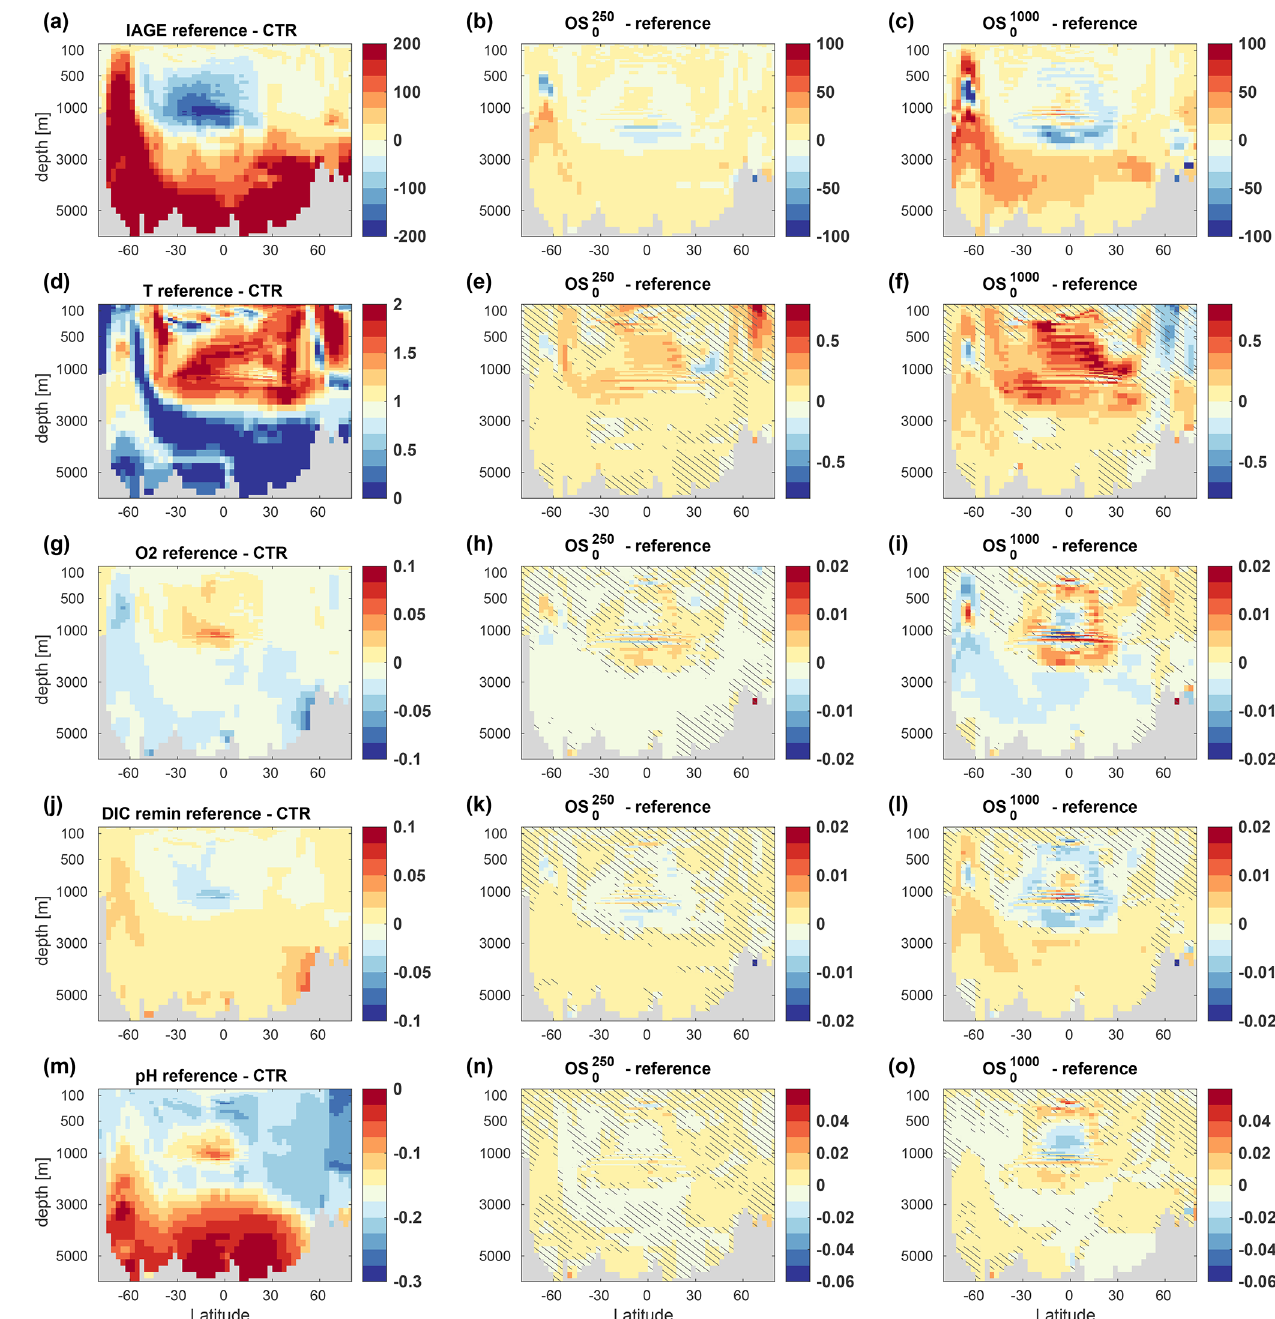
Figure A3. As Fig. 10 but showing REV 195 for a zonal mean section through the Atlantic and for the short overshoot duration.